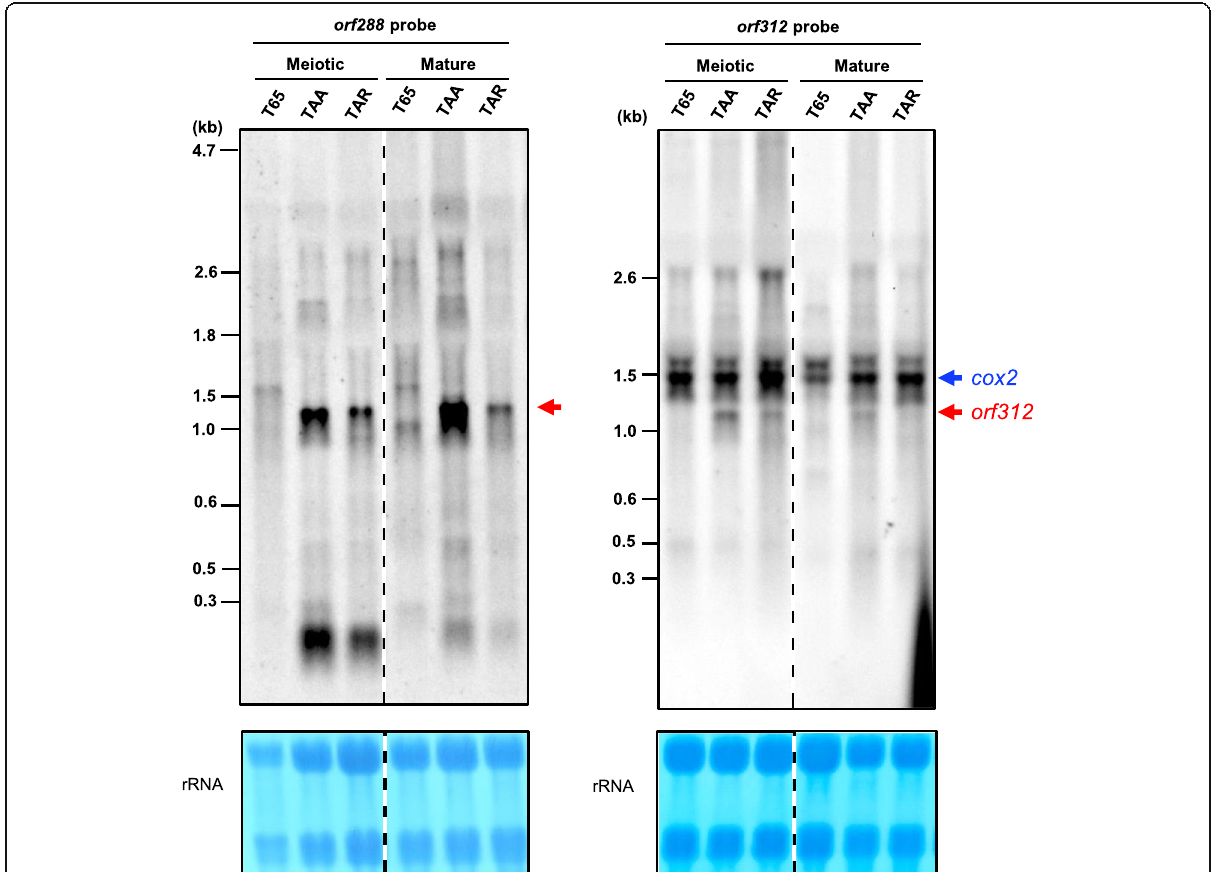
Fig. 6 Northern blot analysis of RNA isolated from spikelets of TAA, TAR and Taichung 65 (T65) at the meiotic stage and anthers at the mature stage. The probes are shown in Fig. 3a. Dashed lines indicate where intervening lanes were removed for clarity. Methylene blue staining of rRNA is shown as a loading